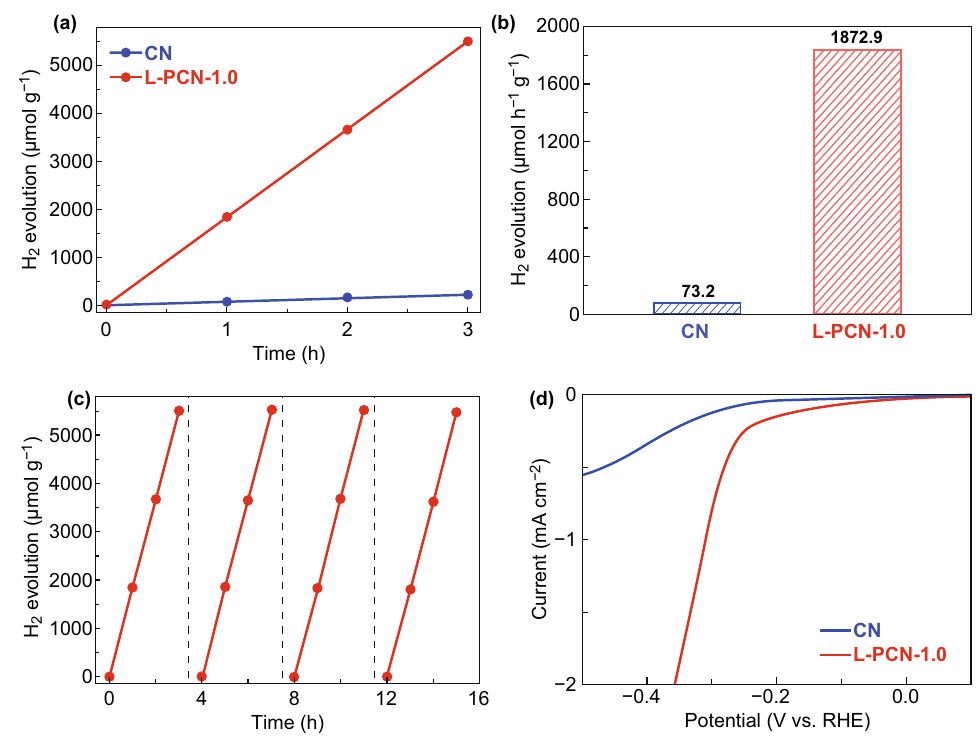
Fig. 7 Photo‑/electrocatalytic activity characterization of CN and L‑PCN. a Photocatalytic activity test of H 2 evolution performance of CN and L‑PCN‑1.0 with 1 wt% Pt under visible light irradiation ( λ > 420 nm). b H 2 evolution rate of CN and L‑PCN‑1.0. c Four cycling test of photocat‑ alytic H 2 evolution of L‑PCN‑1.0. d Linear sweep voltammetry (LSV) plots of CN and L‑PCN‑1.0 catalysts for HER catalysis in 0.5 M H 2 SO